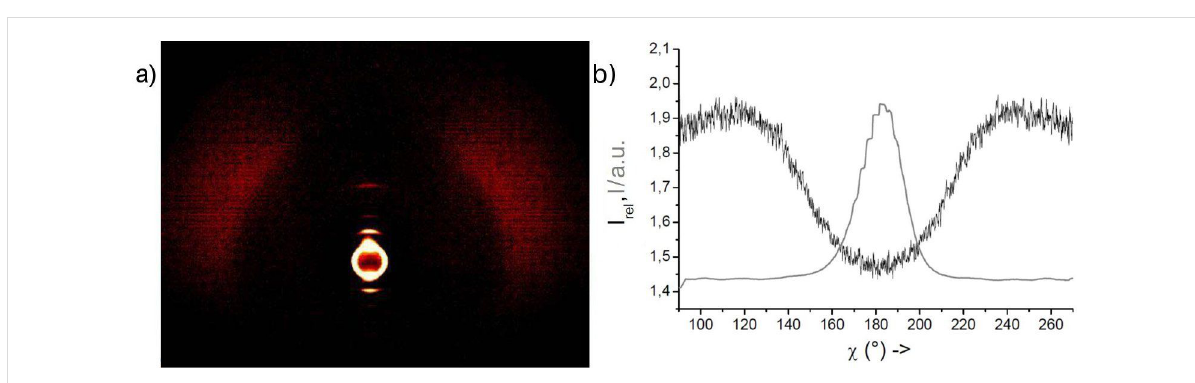
Figure 17: Electro-optical behaviour observed on the fan-shaped texture of compound OH 4d ; U D.C. = 47 V; T = 123 °C; a) − 47 V; b) 0 V; c) +47 V.